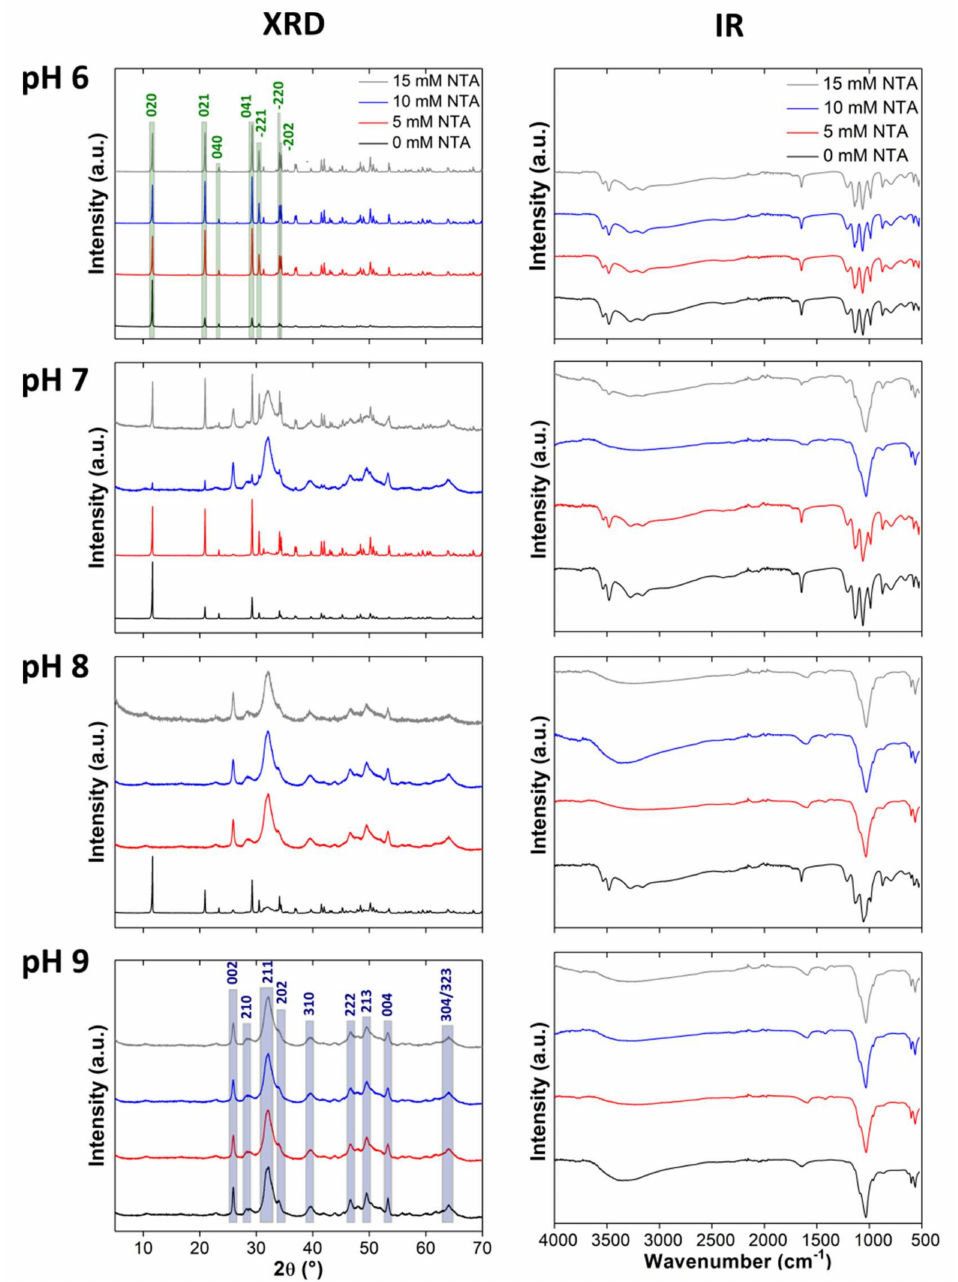
Figure 2. X-ray diffraction (XRD) patterns and infrared (IR) spectra of samples mineralized at different NTA concentrations (0, 5, 10, 15 mM) and pH (6–9). The different intensities in the patterns of the control samples are likely due to sample orientation effects. Highlights indicate dicalcium phosphate dihydrate (DCPD; green) and hydroxyapatite (HAP; blue) signals, respectively. These apply to all images in the manuscript; only the most important reflections are highlighted. a.u.: Arbitrary